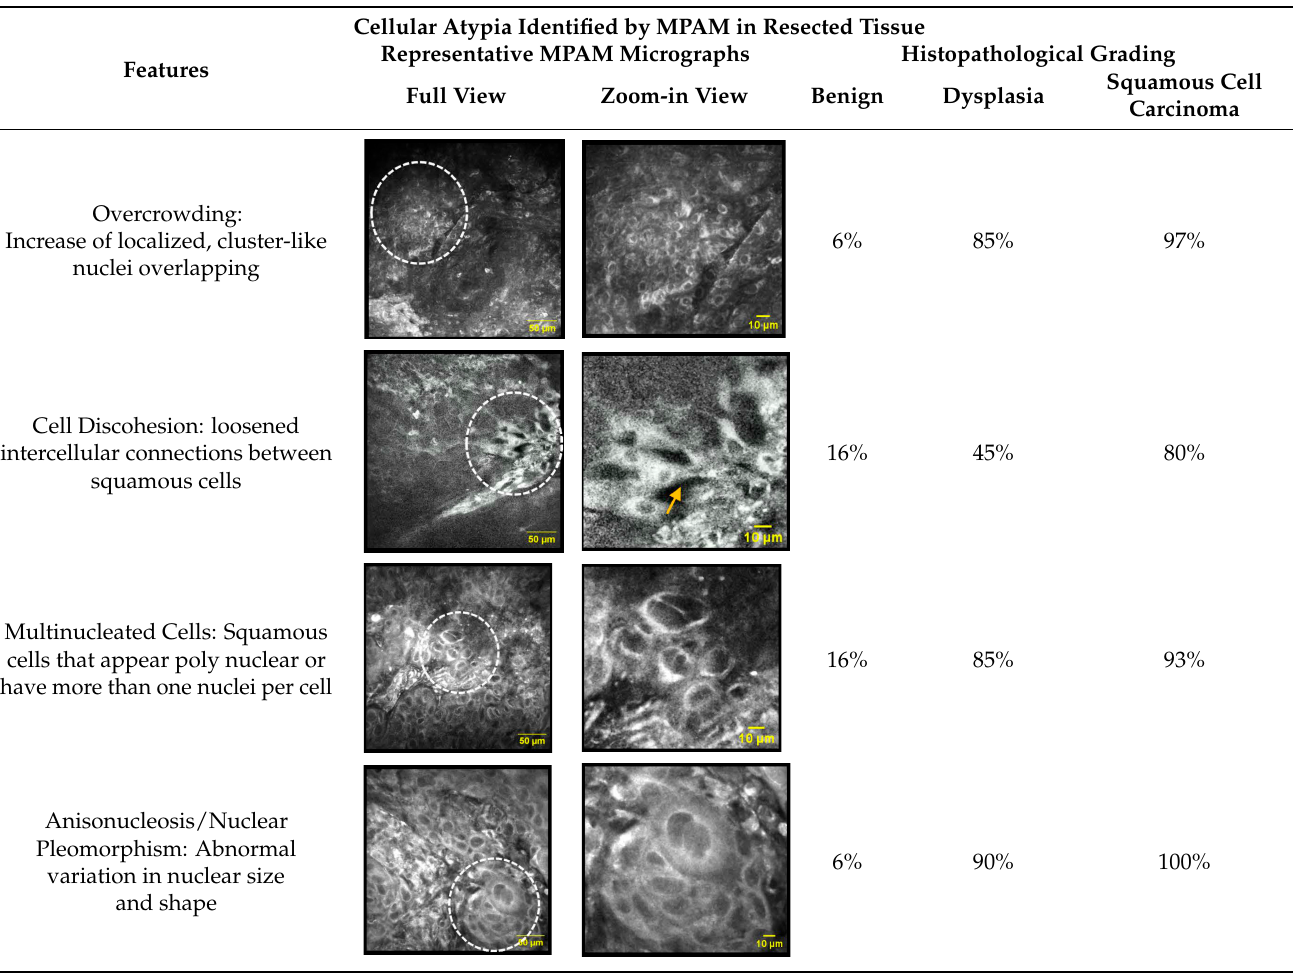
Note. Total 23 Patients, n = 130 Sites.